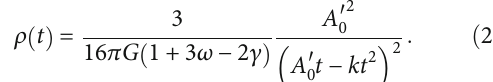
parameter remains the same.